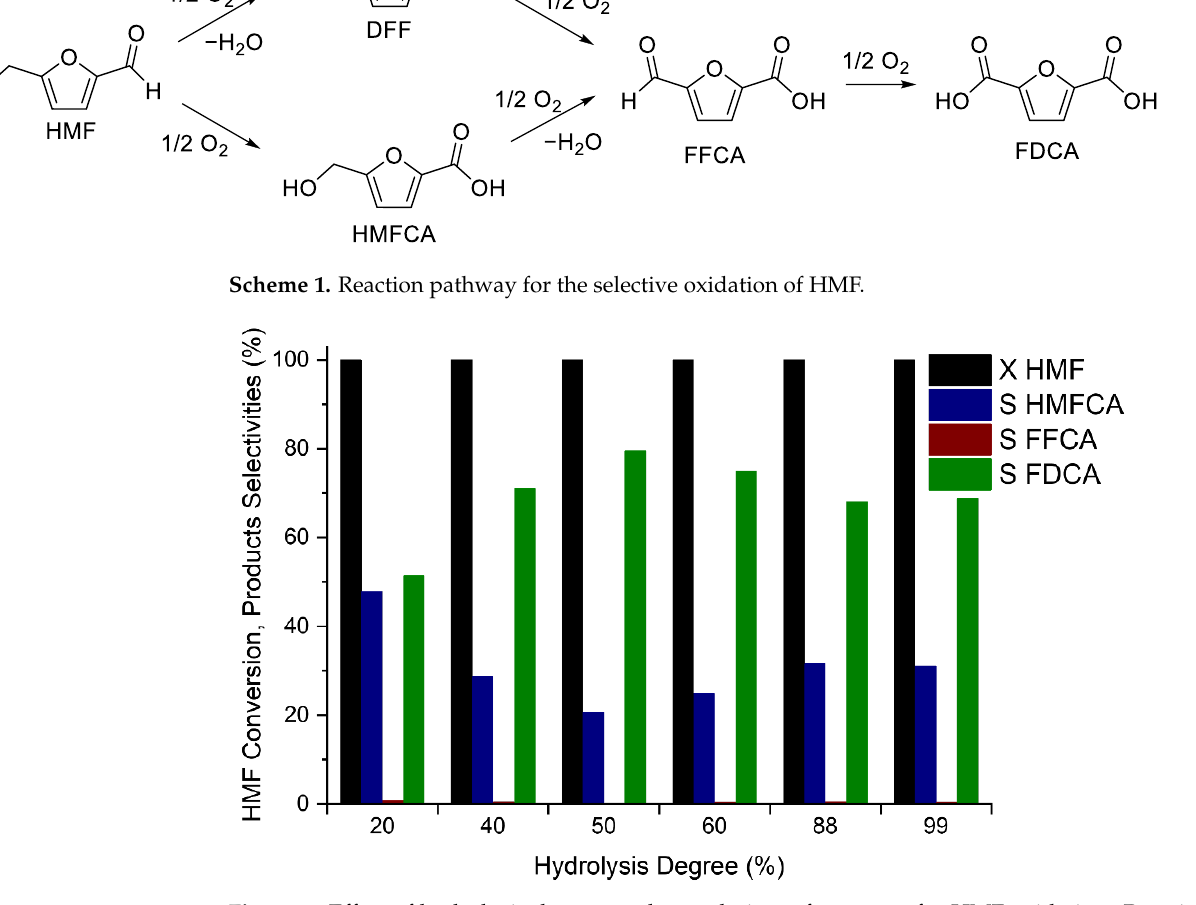
Figure 1. Effect of hydrolysis degree on the catalytic performances for HMF oxidation. Reaction conditions: T = 70 °C, t = 4 h, P = 10 bar O 2 , molar ratios HMF:Au:NaOH = 1:0.01:4.